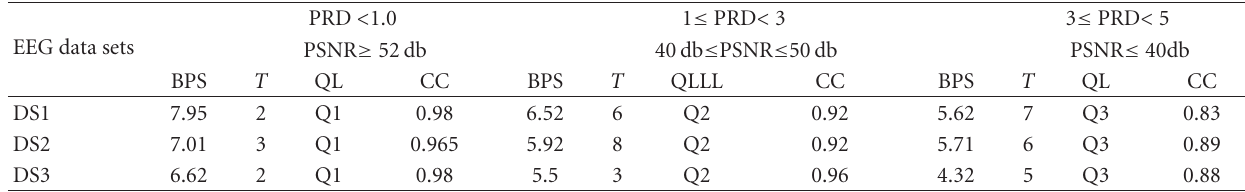
Figure 8: BPS versus PRD and BPS versus SNR characteristics using DS3. Table 7: Selection of quality criteria